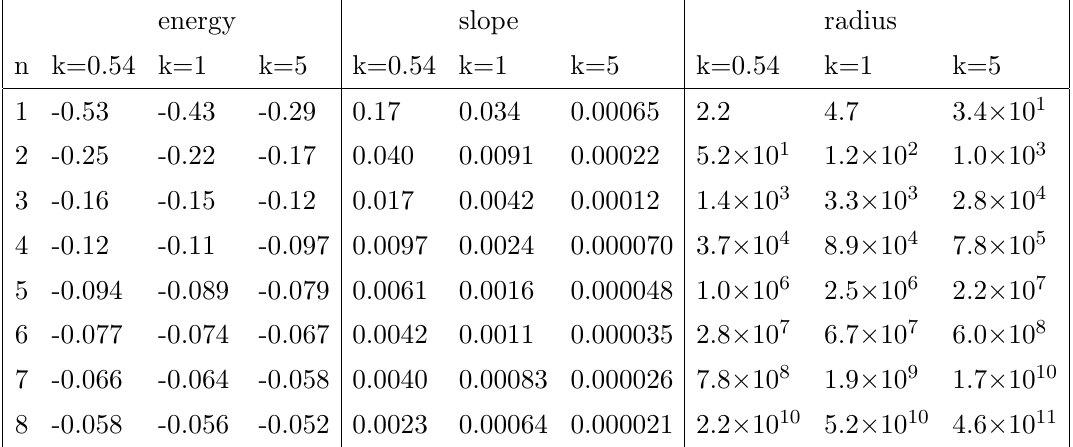
Table 4 . Numerical values for eigenvalues, slopes and radii, with running coupling and for di(cid:11)erent values of the IR cuto(cid:11) k